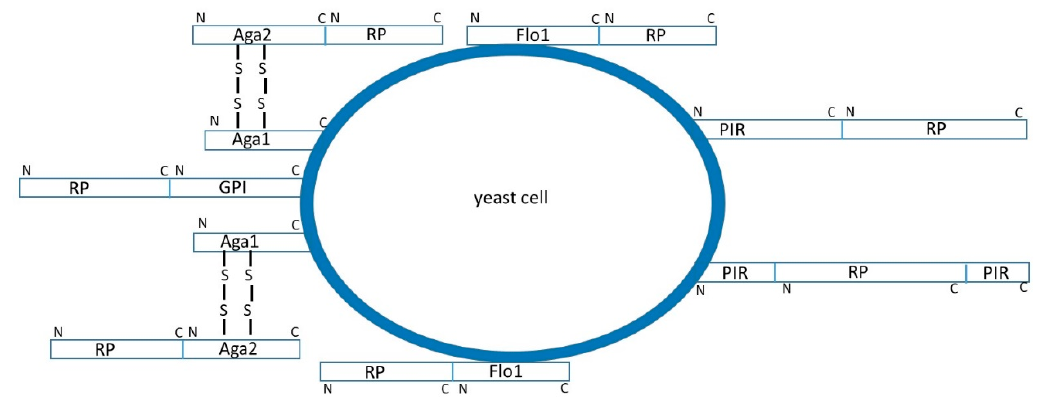
Figure 1. Cell surface anchoring systems in yeast: GPI—cell wall protein of GPI group; PIR—cell wall protein of PIR family; RP—recombinant protein to be anchored; Aga1, Aga2, Flo1—individual cell wall proteins.